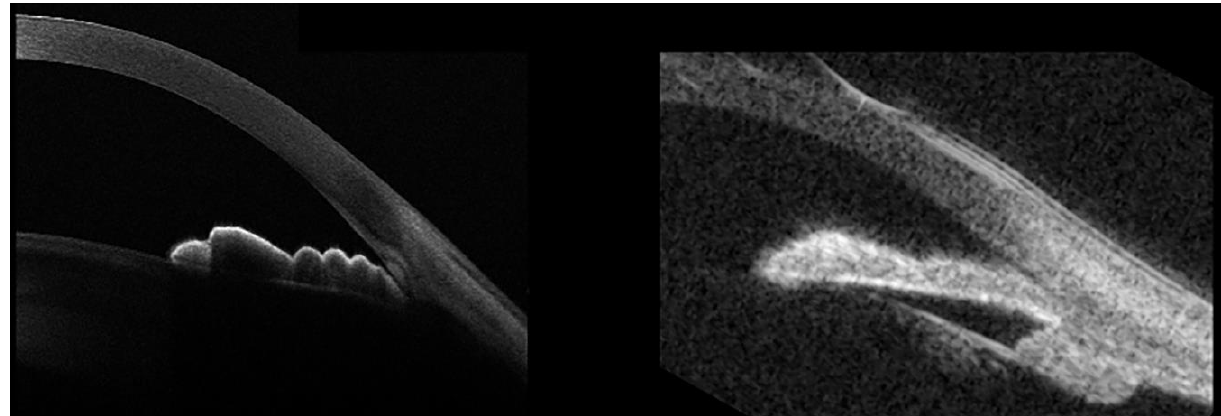
Figure 5. Left panel. MS-39 AS-OCT (CSO, Florence, Italy) from a patient with plateau-iris configuration (PIC). Right panel. Ultrasound biomicroscopy (UBM) of the same eye. While the AS-OCT scan provides details of the iris surface, iris root, and angle structures, its penetration depth does not make it possible to visualize the ciliary body. Conversely, UBM is characterized by poorer definition of the iris and angle structures, but it also allows the evaluation of the ciliary-body position. This is particularly important in PIC, as it is a condition associated with anterior ciliary-body displacement, which displaces the peripheral iris forward, eventually causing appositional angle closure.